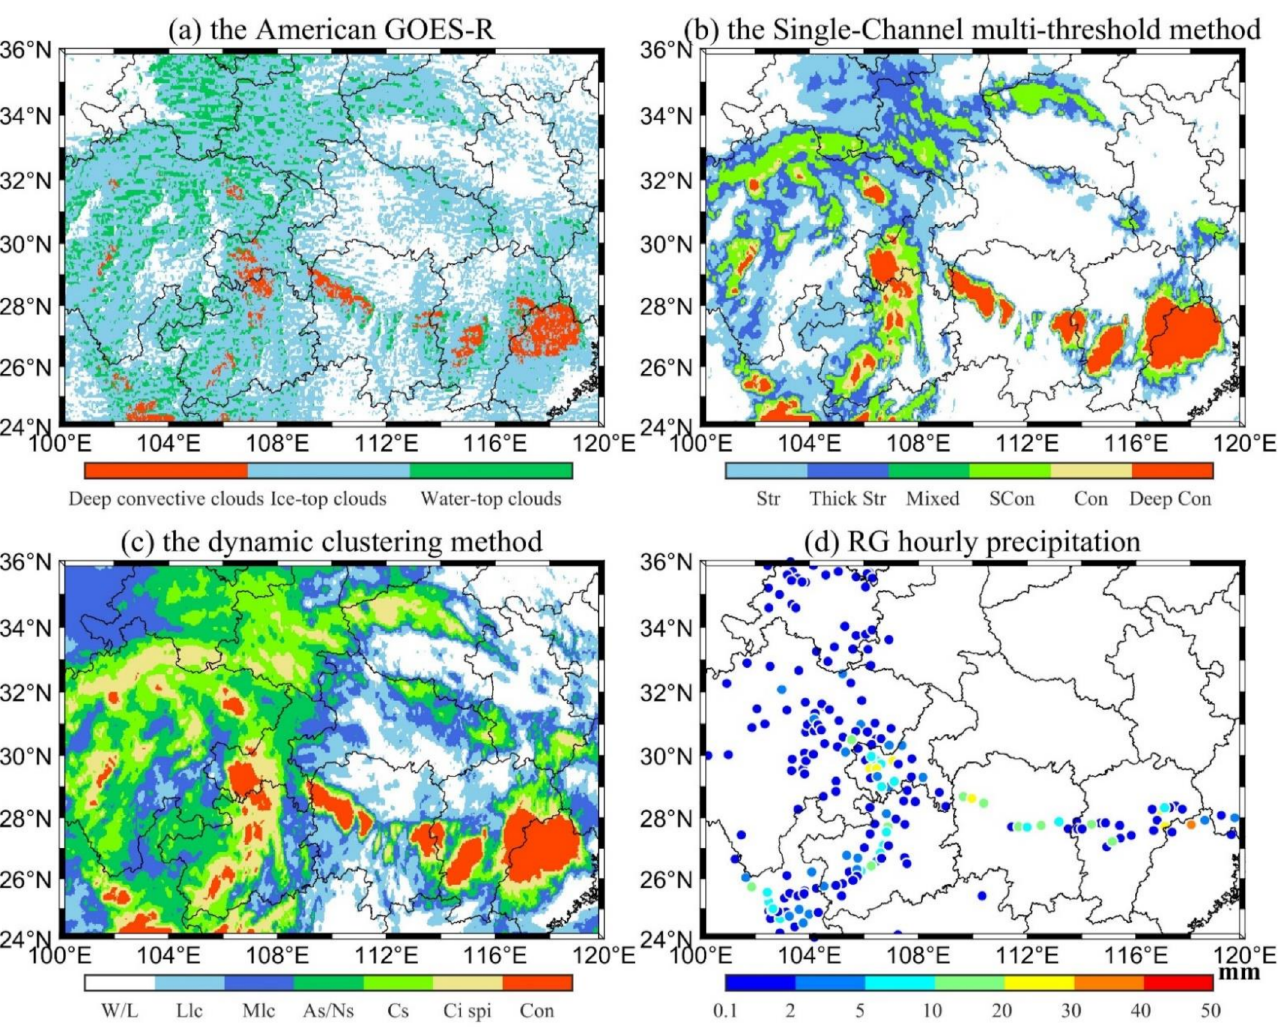
Figure 3. Cloud classification of ( a ) Method 1, ( b ) Method 2, and ( c ) Method 3 and ( d ) the hourly precipitation at 08:00 LST on 1 July 2020, in Western China. (Str: Stratiform clouds, Thick Str: Thick stratiform clouds, Mixed: Mixed clouds, SCon: Shallow convective clouds, Con: Convective clouds, Deep Con: Deep convective clouds, W/L: Water/Land surface, Llc: Low level clouds, Mlc: Middle level clouds, As/Ns: Altostratus/Nimbostratus clouds, Cs: Cirrostratus clouds, Ci spi: Cirrus spissatus